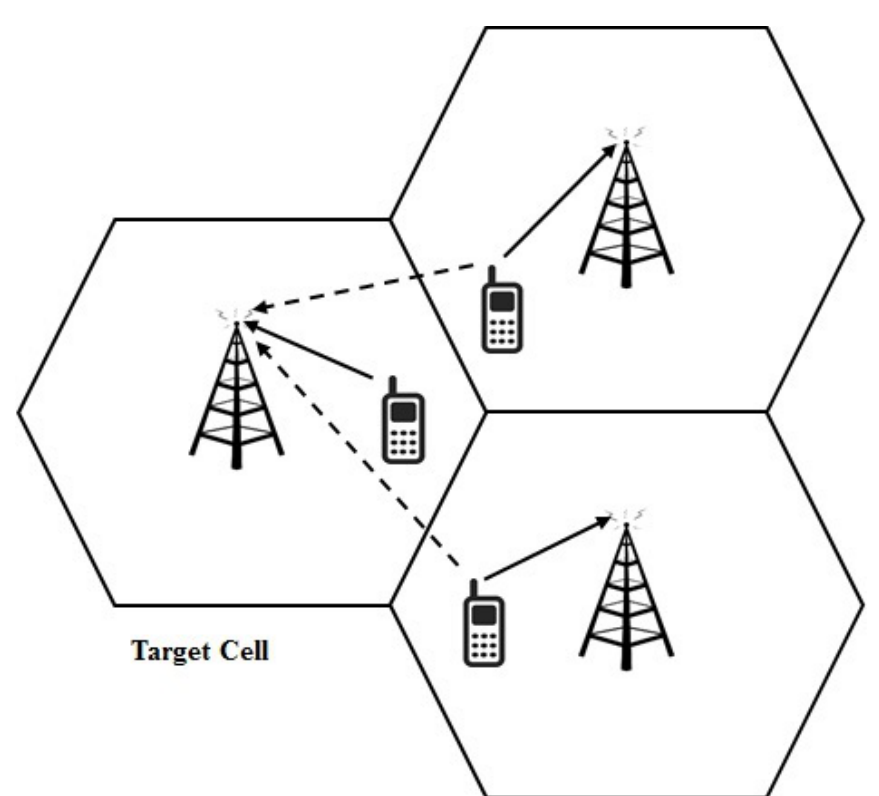
Figure 1. The impact of pilot contamination at the target cell in a multi-cell massive multiple-input– multiple-output (MIMO) system, as all users share the same pilot